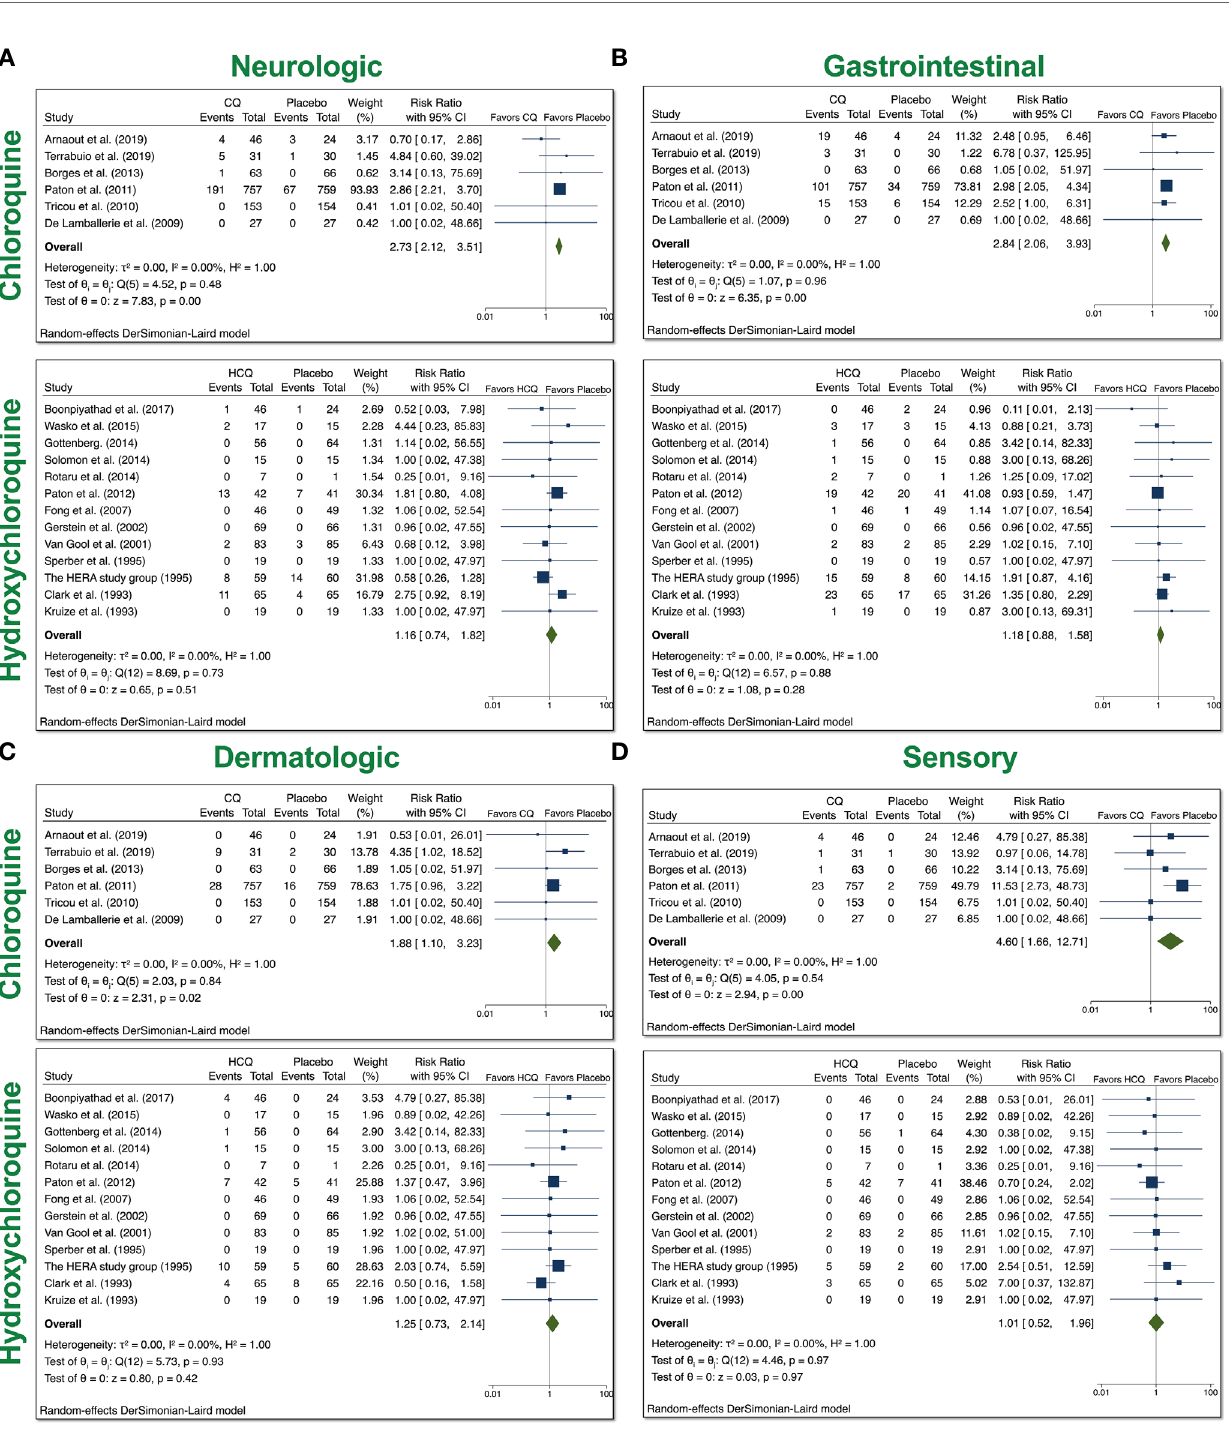
FIGURE 3 | System analyses from trials with CQ and HCQ in non – COVID-19 patients. We performed 6 comparisons between CQ and placebo and 16 comparisons between HCQ and placebo, as evident in the forest plots.. AEs were divided into four groups: (A) neurologic, (B) gastrointestinal (GI), (C) dermatologic, and (D) sensory AEs. Using meta-analyses, we tested heterogeneity between trials, as well as overall effect. Statistical data are displayed in the forest